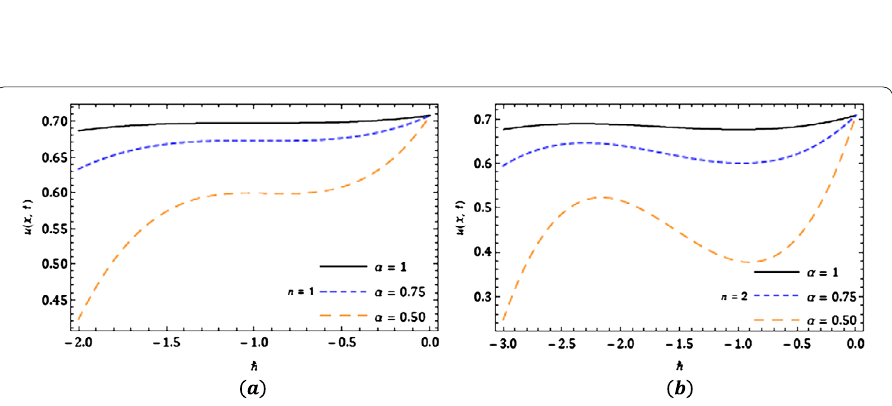
Figure 2 (cid:2) -curves for u ( x , t ) defined in Case 1 with distinct α at x = 1, y = 1, n = 1 and t = 0.01 with ( a ) n = 1 and ( b ) n =